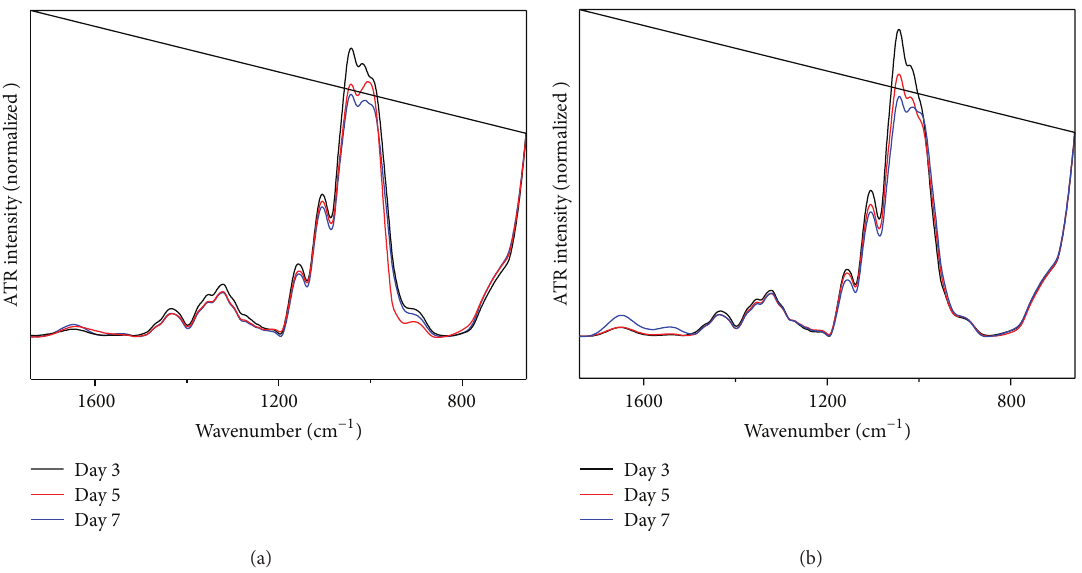
Figure 3: ATR-FTIR spectra of (a) control and (b) RMF exposed BC pellicles in the range from 1800cm −1 to 660cm −1 .